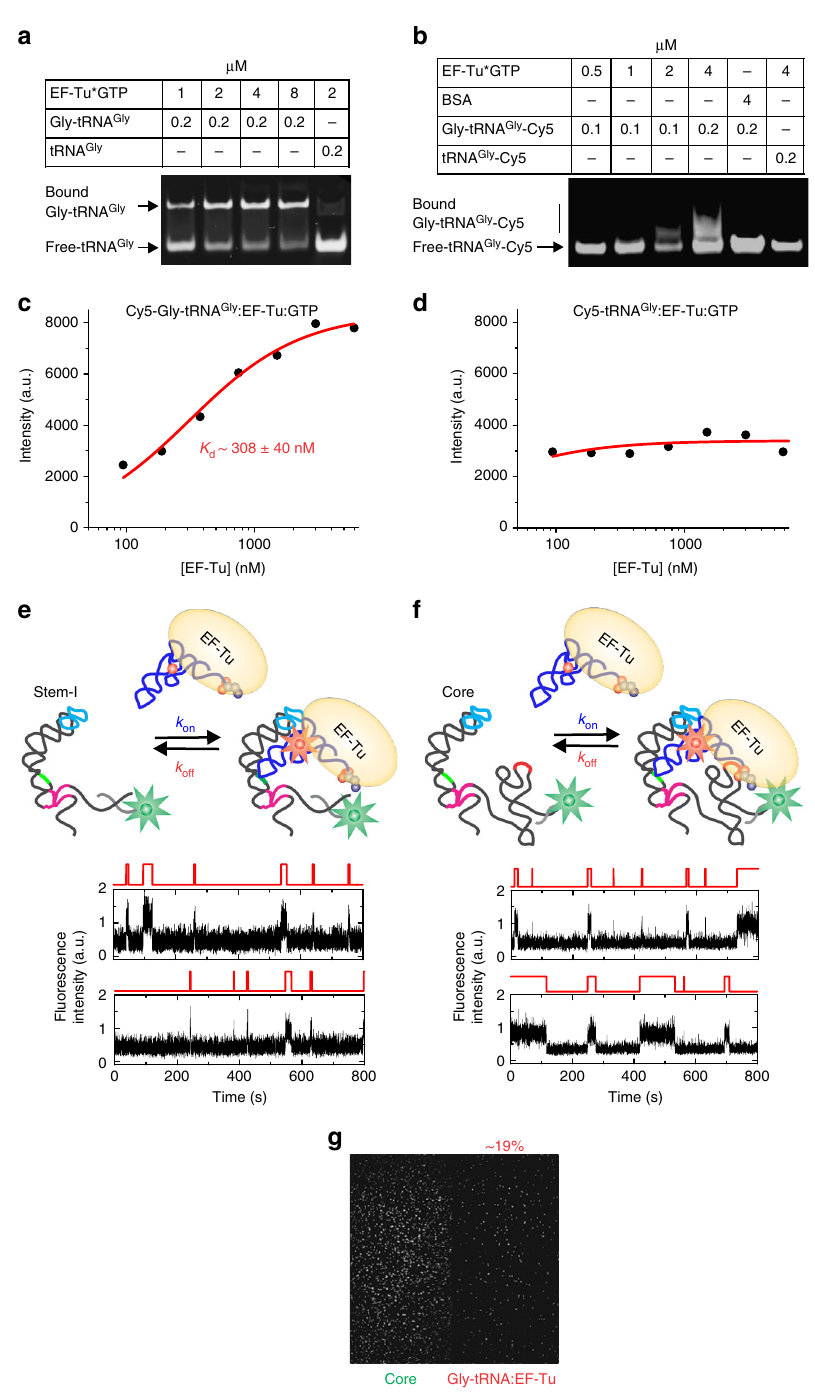
Fig. 7 Kinetic analysis of ternary complex binding to the T-box riboswitch. Native PAGE showing mobility shift of a unlabeled and b Cy5-labeled Gly- tRNA Gly binding to EF-Tu. Estimation of apparent K d for EF-Tu binding to c Cy5-Gly-tRNA Gly and d Cy5-tRNA Gly using RNase protection assays with fi ts to non-cooperative ( n = 1) Hill equations. Schematic and representative single-molecule traces showing Gly-tRNA Gly :EF-Tu:GTP binding to e Stem-I and f the core T-box riboswitch. g Average image of the fi rst 30 frames (3 s) for Gly-tRNA Gly :EF-Tu:GTP binding to the core T-box tRNA Gly by EF-Tu:GTP against RNase degradation followed by found the transcribed Gly-tRNA Gly and U46 Cy5-labeled Gly- tRNA Gly to bind EF-Tu:GTP with similar apparent af fi nities nitrocellulose binding 32,33 yielded a more realistic, higher-af fi nity (~1.5 μ M; Fig. 7a, b and Supplementary Fig. 5e), comparable to apparent K d of 310 ± 40 nM (Fig. 7c), establishing the fraction of Cy5-Gly-tRNA Gly bound to EF-Tu:GTP as >80% under the previously measured af fi nities based on a similar assay 31 . As expected, the ternary complex was not observed for non- conditions of our single-molecule fl uorescence coincidence aminoacylated tRNA Gly or Cy5-tRNA Gly (Fig. 7a, b), con fi rm- assays. As expected, EF-Tu did not protect the uncharged tRNA against RNase degradation, further con fi rming the speci fi c ing the speci fi city of EF-Tu:GTP for aminoacylated tRNA. binding to the Cy5-Gly-tRNA Gly (Fig. 7d). Measuring instead the af fi nity through the protection of Cy5-Gly-